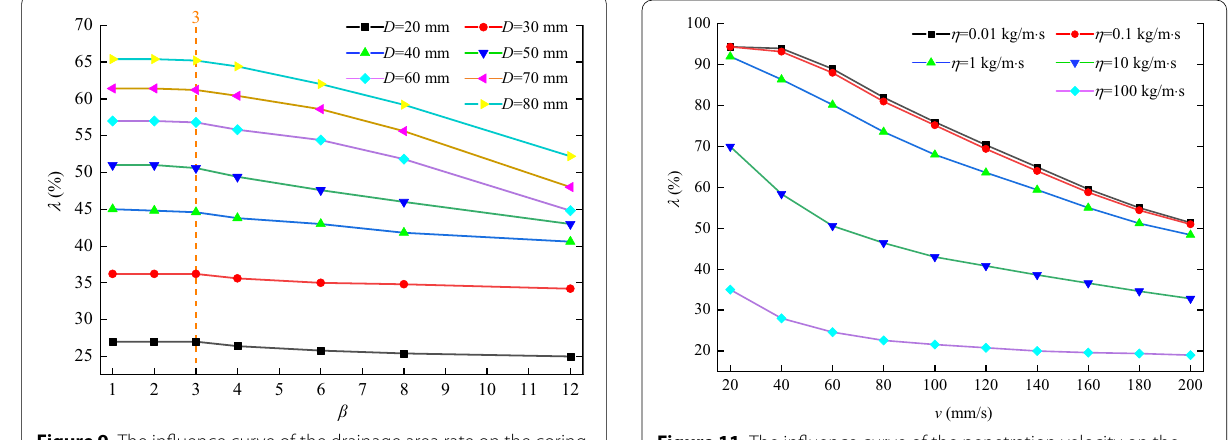
Figure 11 The influence curve of the penetration velocity on the coring